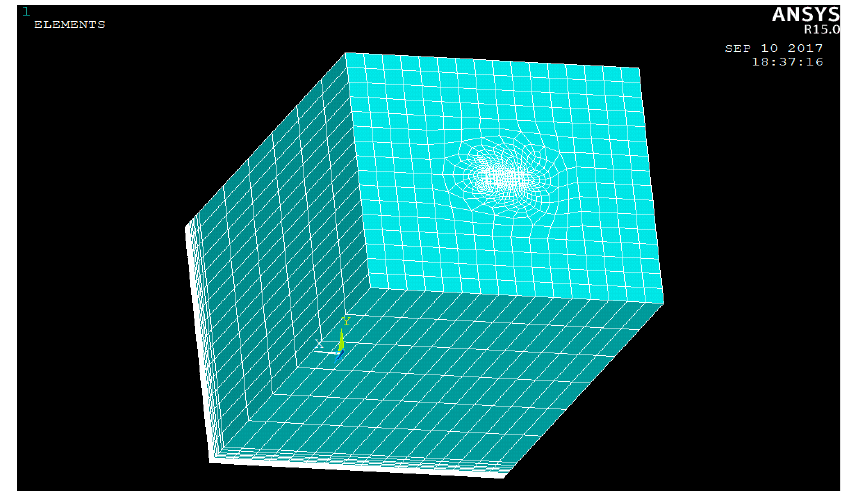
Figure 4. Schematic diagram of 3D model.